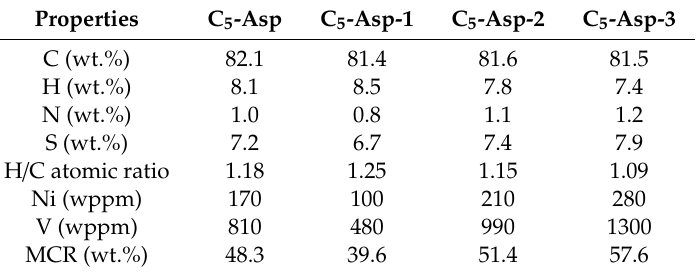
Figure 1. The procedure for fractionation of C 5 -Asp. Table 1. Properties of C 5 -Asp feedstock and its subfractions.